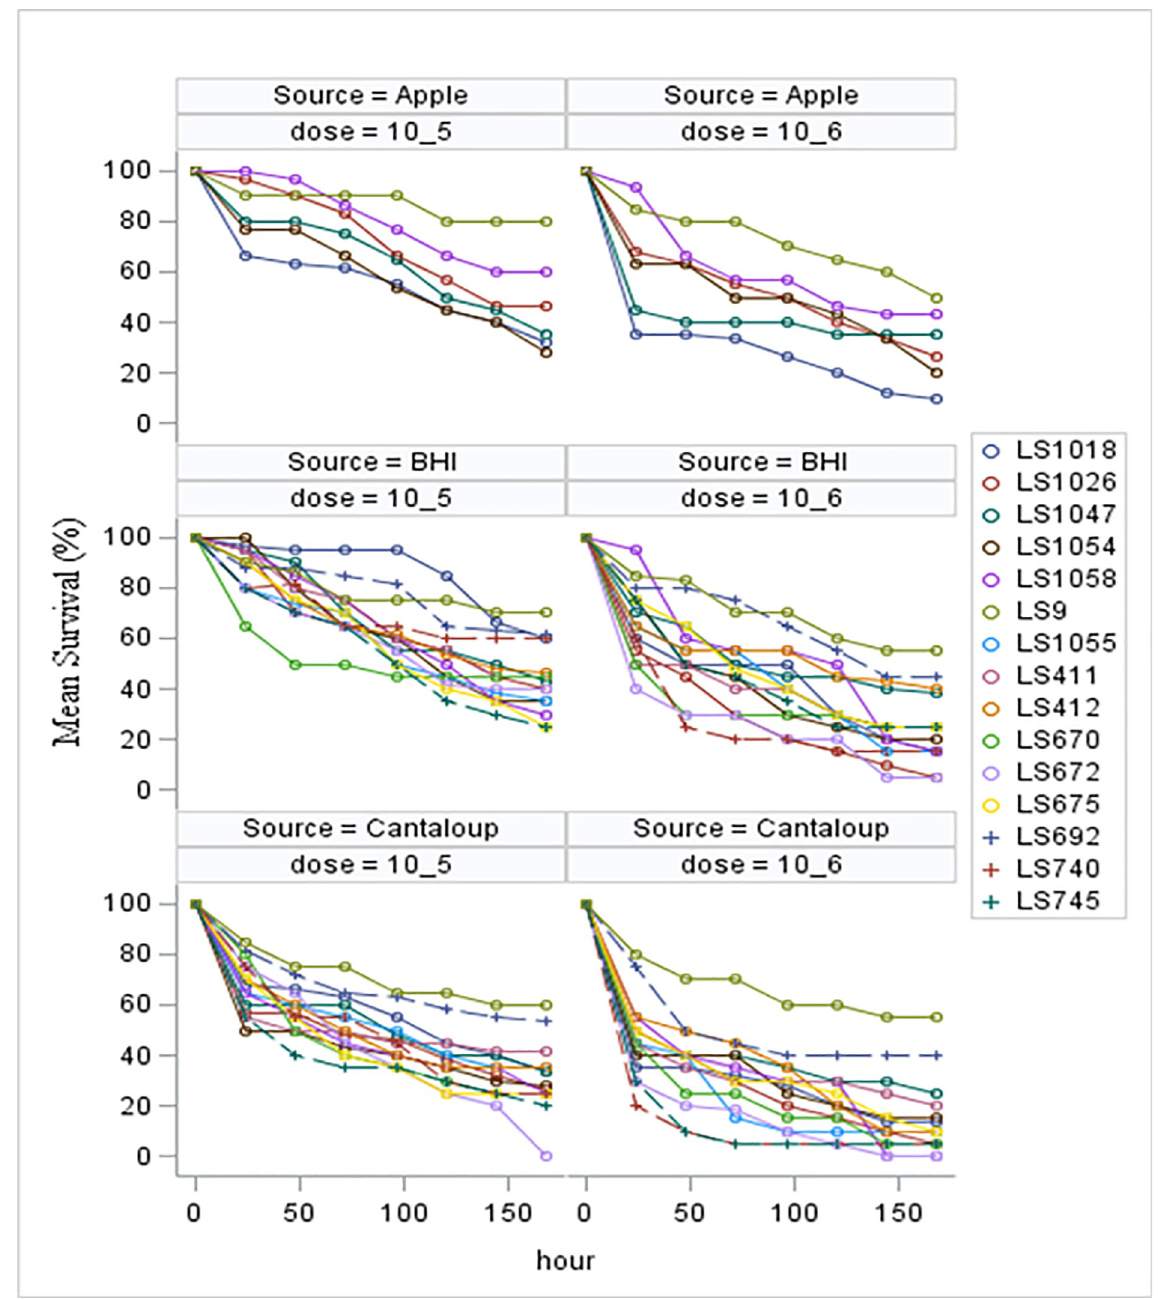
Fig 3. Virulence of L . monocytogenes strains (represented as LT 50 ) in Galleria larvae inoculated with the pathogen at the concentrations of (A) 10 6 CFU/larva and (B) 10 5 CFU/larva. Prior to the inoculation, Lm was recovered from BHI (), cantaloupe fragments ( & ) and apple fragments ( Δ ), separately, after 5 days at 10˚ C. Nonpathogenic L . innocua was also included in the panel, but we were not able to establish LT 50 values since number of dead larvae did not reach 50% over the monitoring period of seven